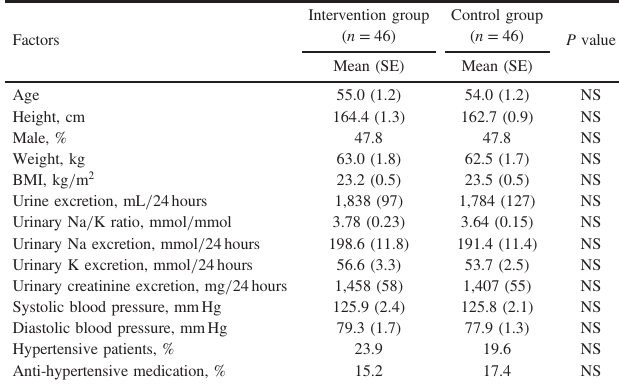
Table 1. Baseline characteristics of study participants, 2012